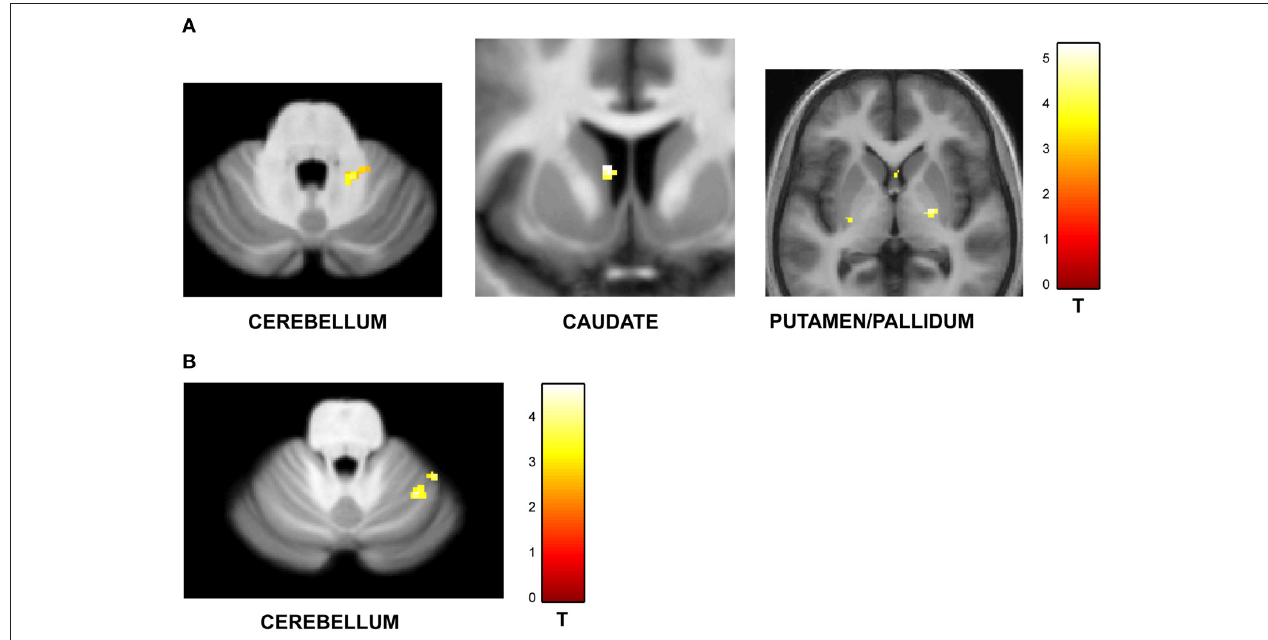
FIGURE 4 | Functional imaging results: effect of task context. BOLD activations are shown for brain areas whose activity was found to be differentially modulated for trials with identical task structure (4 intervals with 20–25% jitter) but different context provided by the variable temporal structure in the jitter condition and the variable memory load in the number-of-intervals condition. All activations (except cerebellar activations on SUIT template) are displayed on the average normalized structural across all participants at a threshold of p < 0.001 (uncorrected). MNI coordinates and t- values are listed in Tables 3A,B respectively. (A) Brain areas with greater response for jitter vs. number of intervals condition. BOLD response in the cerebellum, caudate and putamen was found to be significantly modulated and higher during the jitter compared to the number-of-intervals condition for identical trials. (B) Brain areas with greater response for number of intervals vs. jitter condition. BOLD response in the cerebellum only was found to be higher for the identical trials in the number-of-intervals compared to the jitter condition.